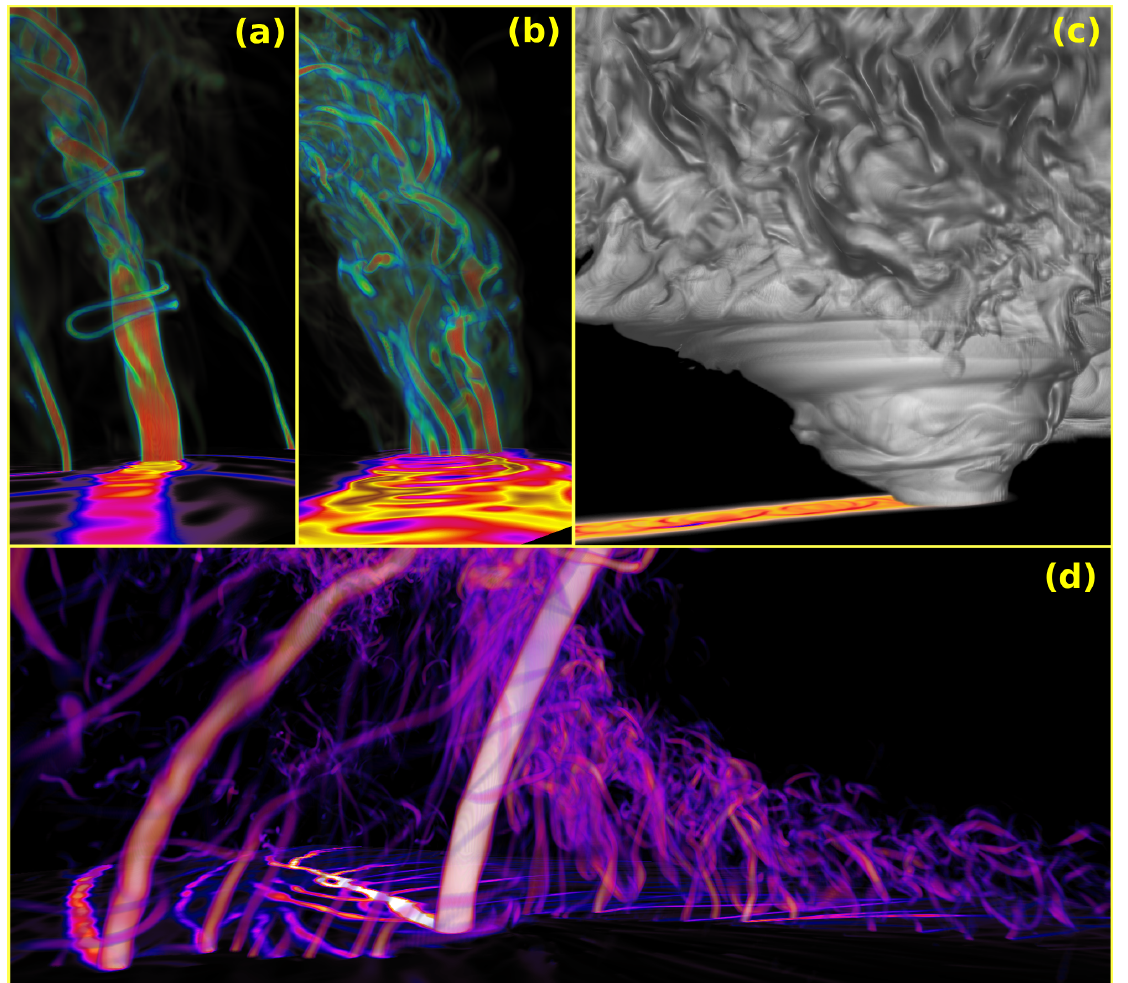
Figure 6. Imagery created with VAPOR Version 3 of a 10-m supercell simulation. ( a ) Volume-rendered cyclonic vertical vorticity, highlighting the 3D structure of the tornado shortly after formation. The 2D surface field traces the maximum surface cyclonic vertical vorticity, providing a representation of the tornado’s path. The view is following the tornado’s path. ( b ) Same as in ( a ), but later in the simulation when the tornado exhibits a multiple vortex structure. ( c ) Volume-rendered cloud mixing ratio, with parameters chosen to present a quasi-photorealistic view of the cloud field. The 2D surface field traces the minimum pressure found in the tornado’s path. ( d ) Same as in ( a , b ), but a different, wider view and utilizing different opacity and colormap choices. The vortex to the left, which merges with the tornado later in the simulation, is weaker than the nascent tornado, as evidenced by the vortex’s more transparent and darker visual presentation and